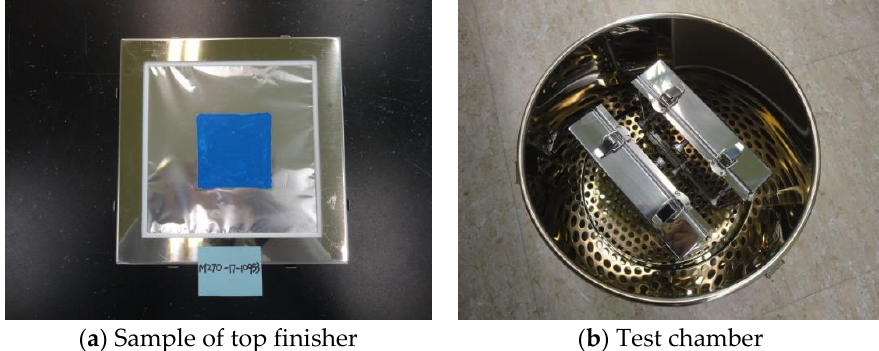
Figure 6. Pollutant emission test.